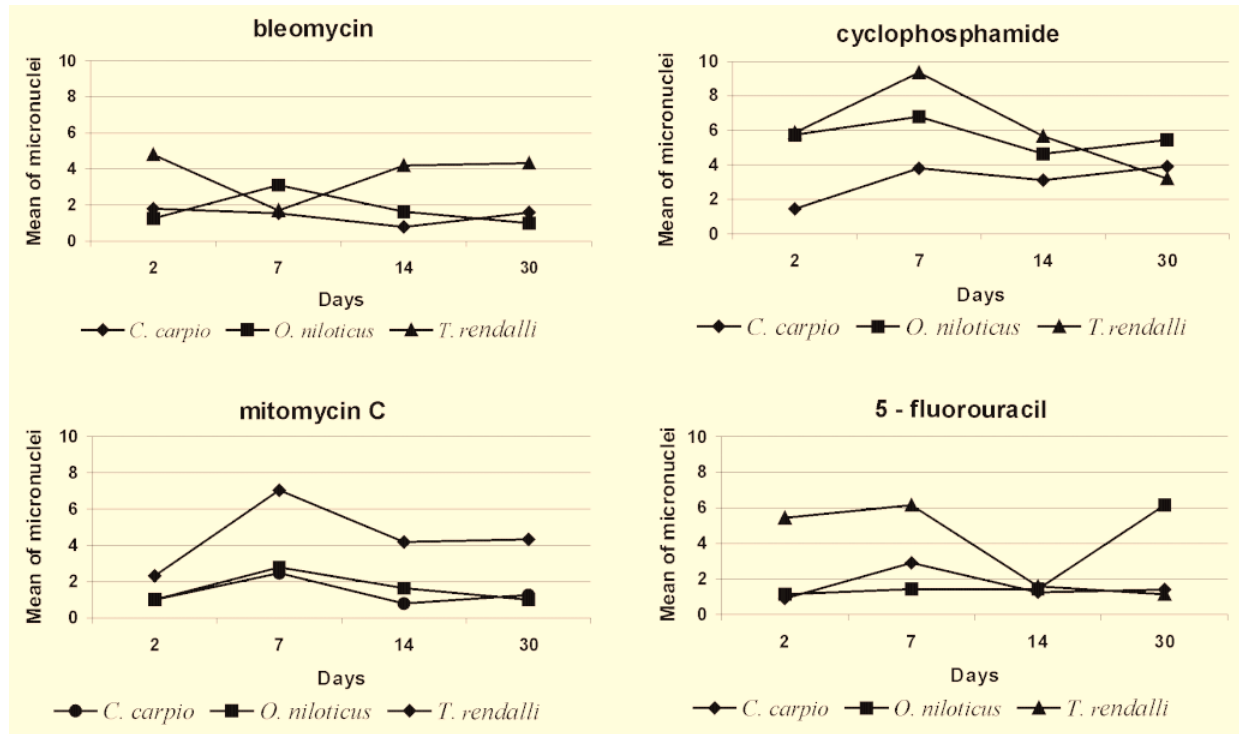
Figure 1 - Comparisons of micronucleus frequency induced by several clastogens at different post-treatment